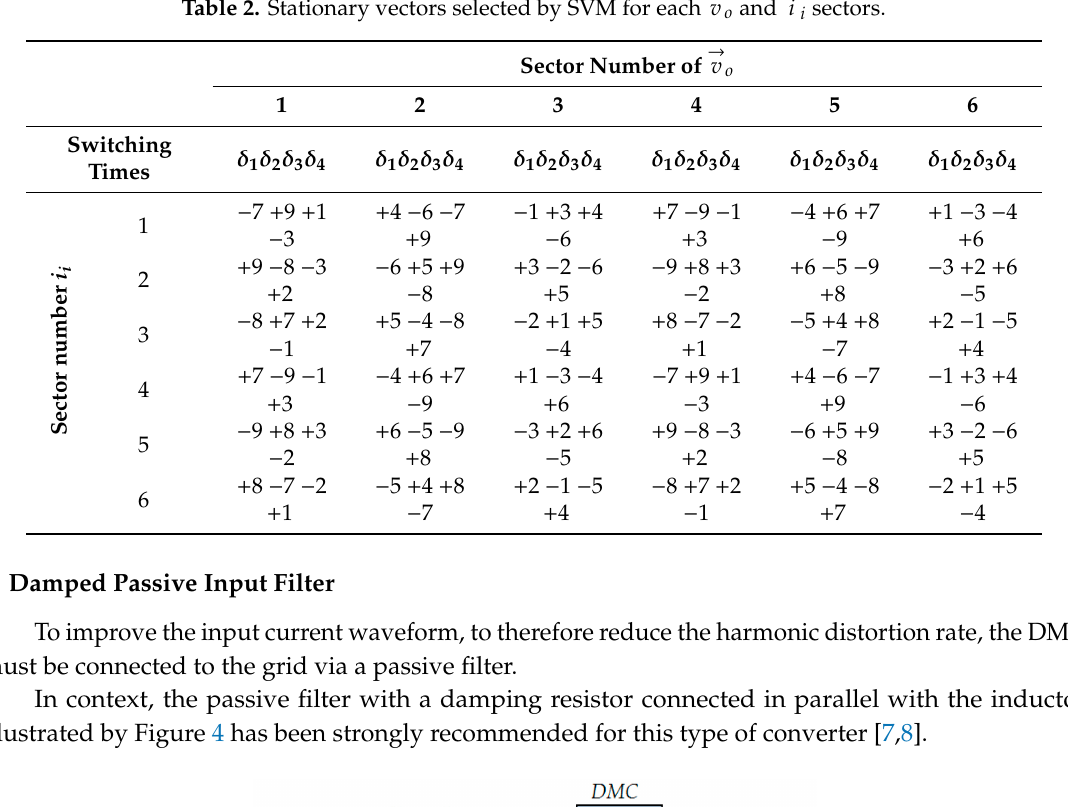
Table 2. Stationary vectors selected by SVM for each